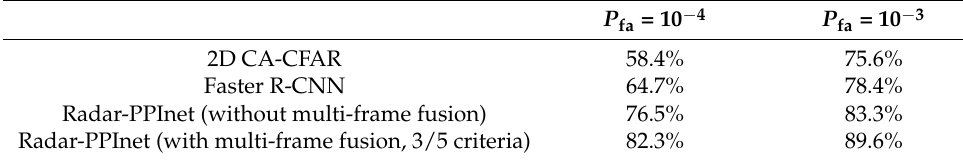
Figure 14. Detection results comparison of the open sea radar PPI image using different methods: ( a ) 2D CA-CFAR; ( b ) Faster R-CNN; ( c ) Radar-PPInet. Table 4. Detection probability comparison with different P fa (coastal environment).